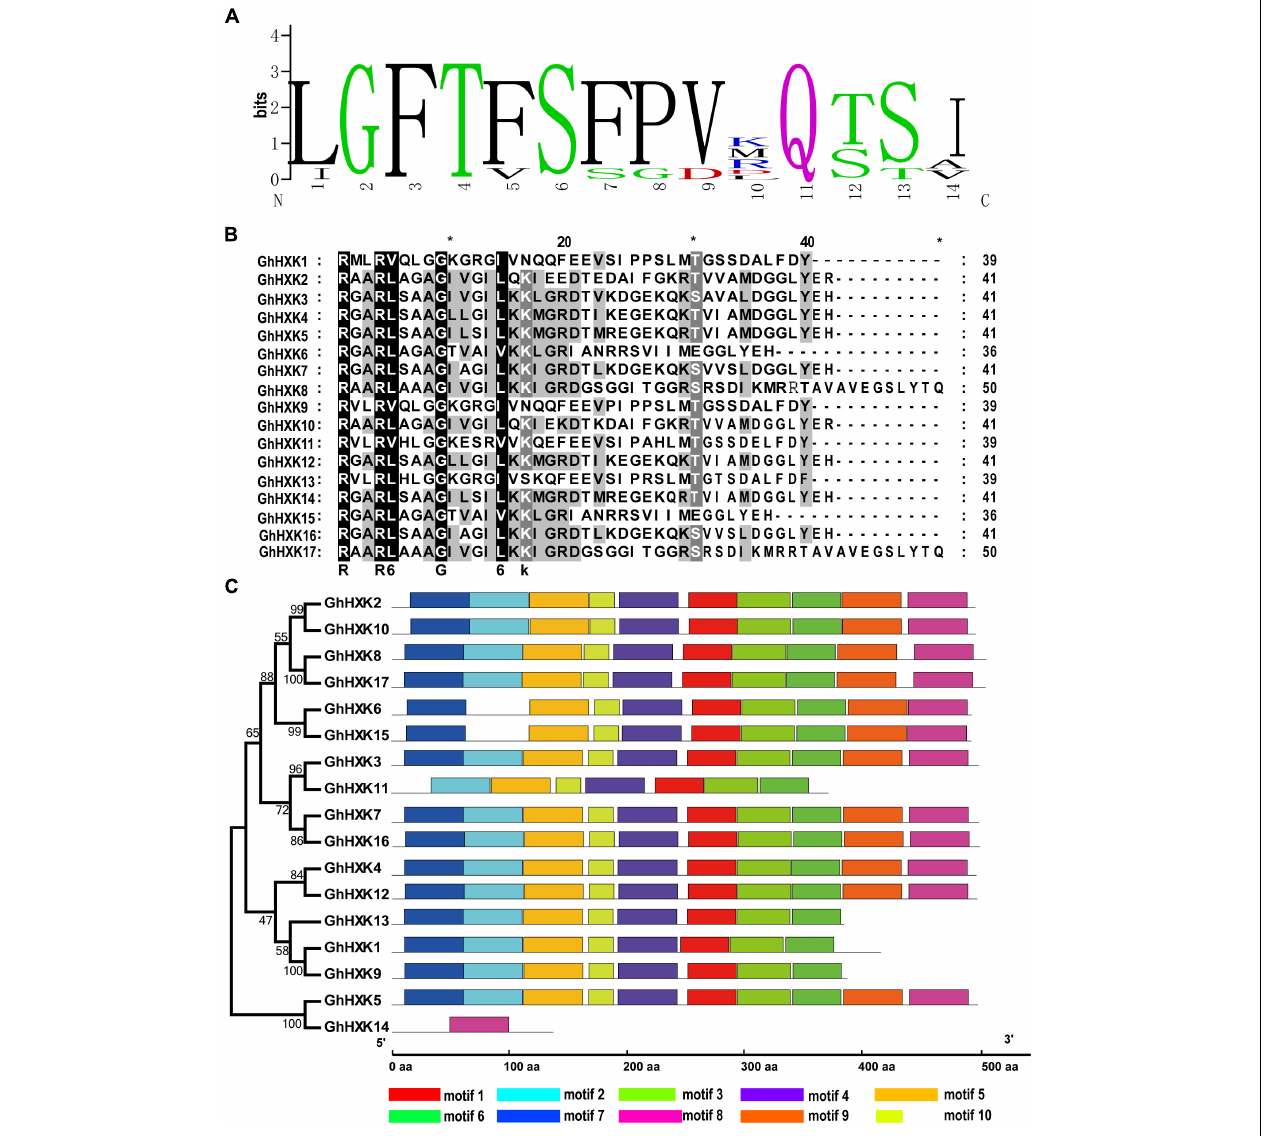
FIGURE 5 | Protein features of HXKs in G. hirsutum L. (A) The weblogo of GhHXK protein glucose-binding sites. (B) The conserved adenosine binding sites of GhHXKs. (C) The motifs of HXK sequences from G. hirsutum